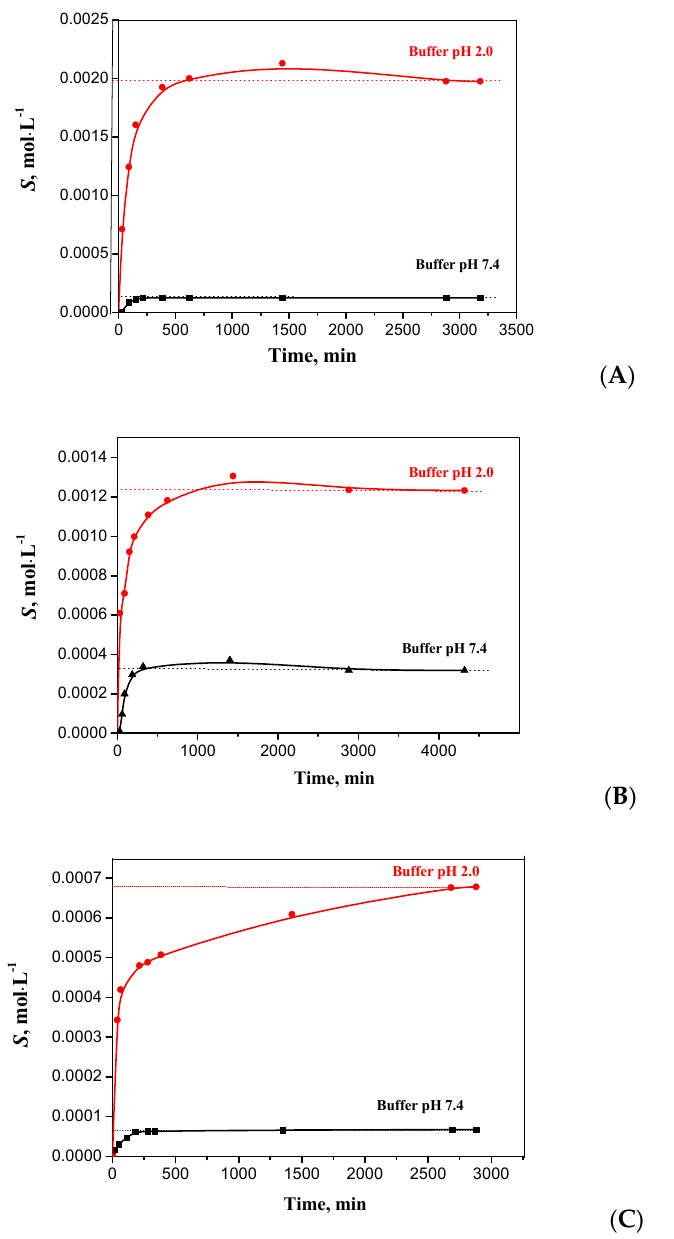
Figure 2. Solubility kinetic profiles of compounds I ( A ), II ( B ), and III ( C ) in buffer solutions (pH 2.0 and 7.4) at 298.15 K (dotted lines corresponds to equilibrium